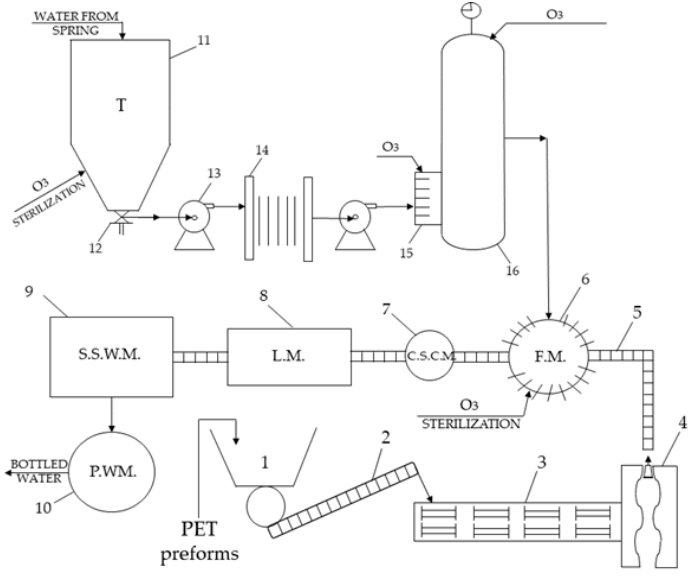
Figure 1. Technological scheme of water bottling process.